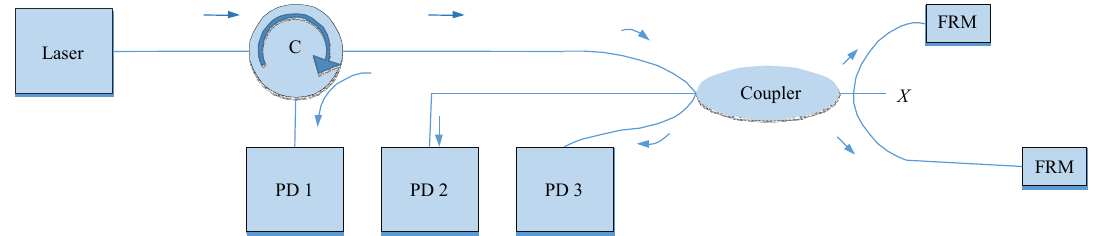
Fig . 3 Michelson interferometer structure diagram based on the 3 × 3 fiber